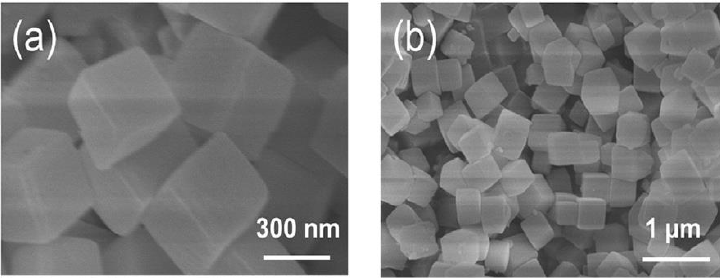
Figure 5. SEM images of the CoMoS x nanocubes. ( a ) 300 nm magnification, ( b ) 1 µ m magnification. Reproduced with permission from Reference [37], Elsevier 2018.